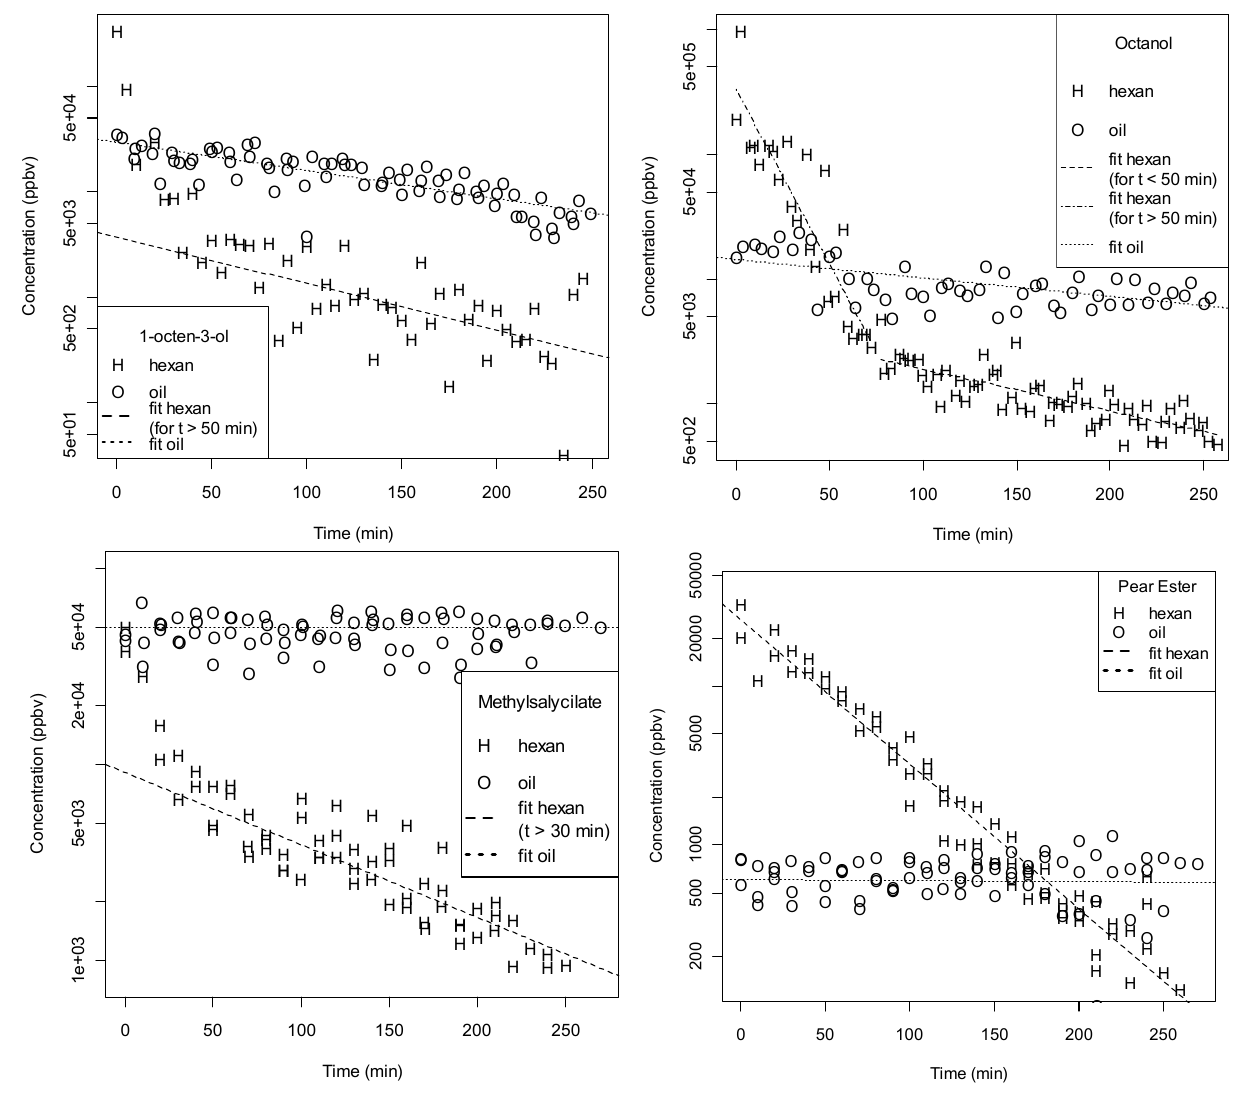
Figure 3. Time evolution (over puffs) of the maximum concentration in the gas emitted by cartridges loaded with a stimulus compound (1-octen-3-ol, 1-octanol, methyl salycilate, or pear ester). The points indicate the solvent: H for hexane and O for paraffin oil. Concentration is estimated from the concentration of the M+1 isotopologue (13.8%). Dashed lines indicate the best fits on the paraffin oil and hexane data